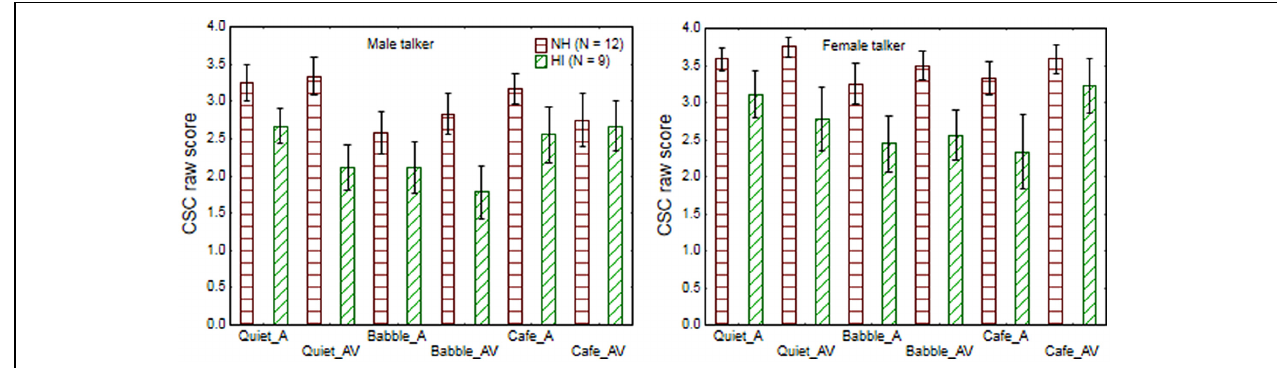
FIGURE 2 | The average CSC scores obtained by younger normal-hearing and older hearing-impaired participants when listening to a male talker (left graph) and female talker (right graph) in quiet, babble-noise (Babble), and in cafeteria-noise (Cafe) with audio-only (A) or audio-visual (AV) cues.